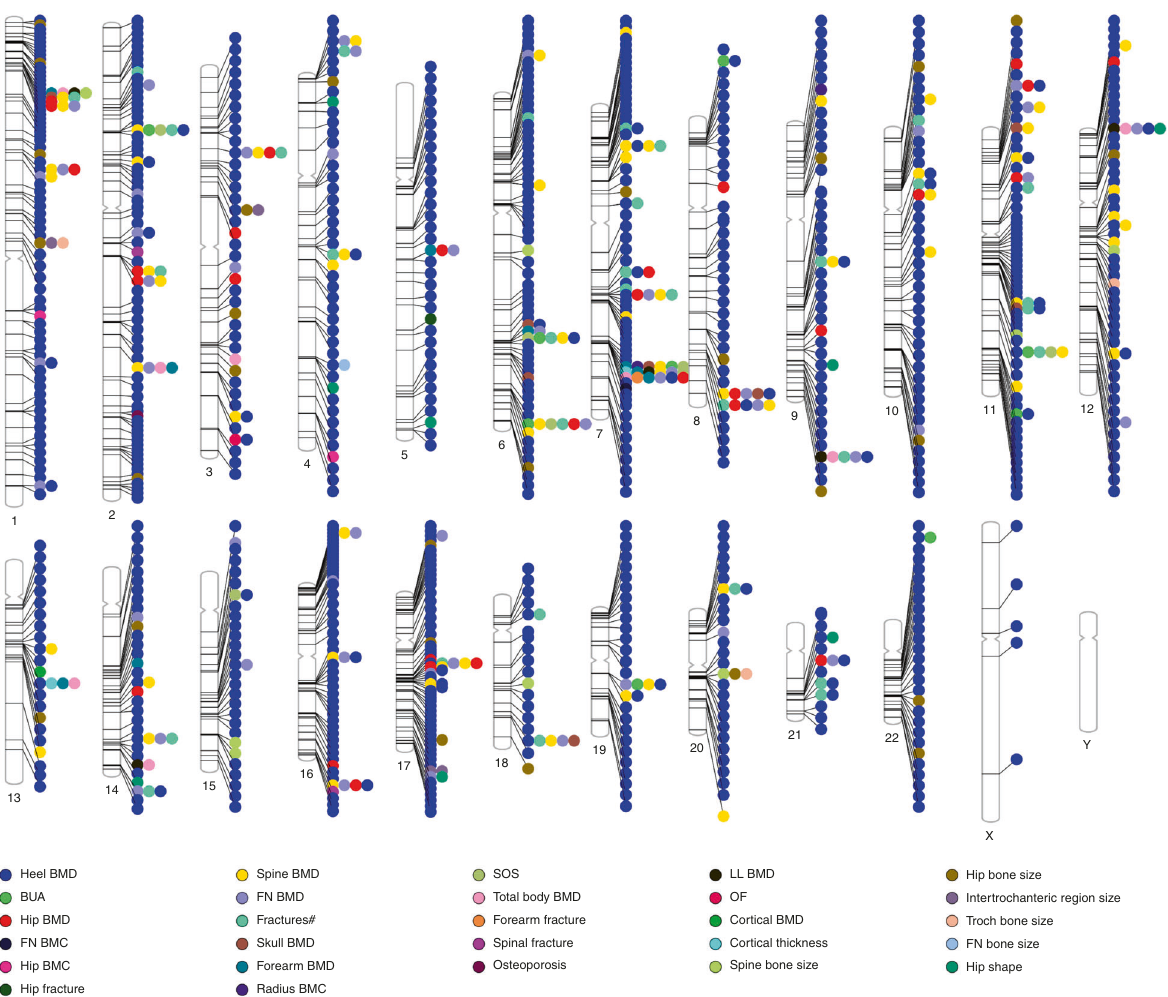
Fig. 2 Genetic loci reported by the GWAS catalog for osteoporosis and related traits. # Fracture occurring at any site, except fi ngers, toes and skull, after age 18. BMC bone mineral content, BMD bone mineral density, BUA broadband ultrasound attenuation, FN femoral neck, LL lower limbs, OF osteoporotic fractures, SOS speed of